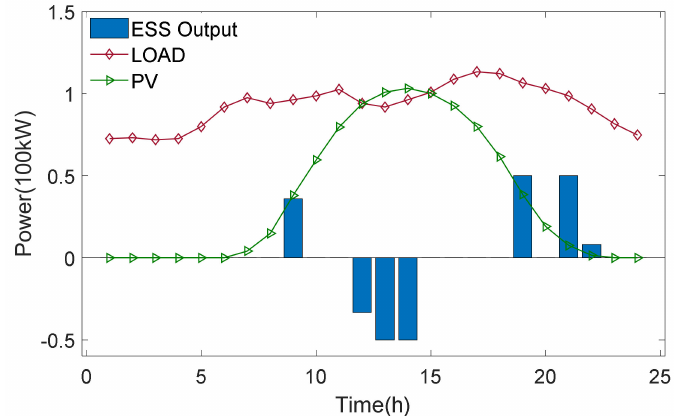
Figure 8. The fourth node load, photovoltaic (PV), and storage output curve.